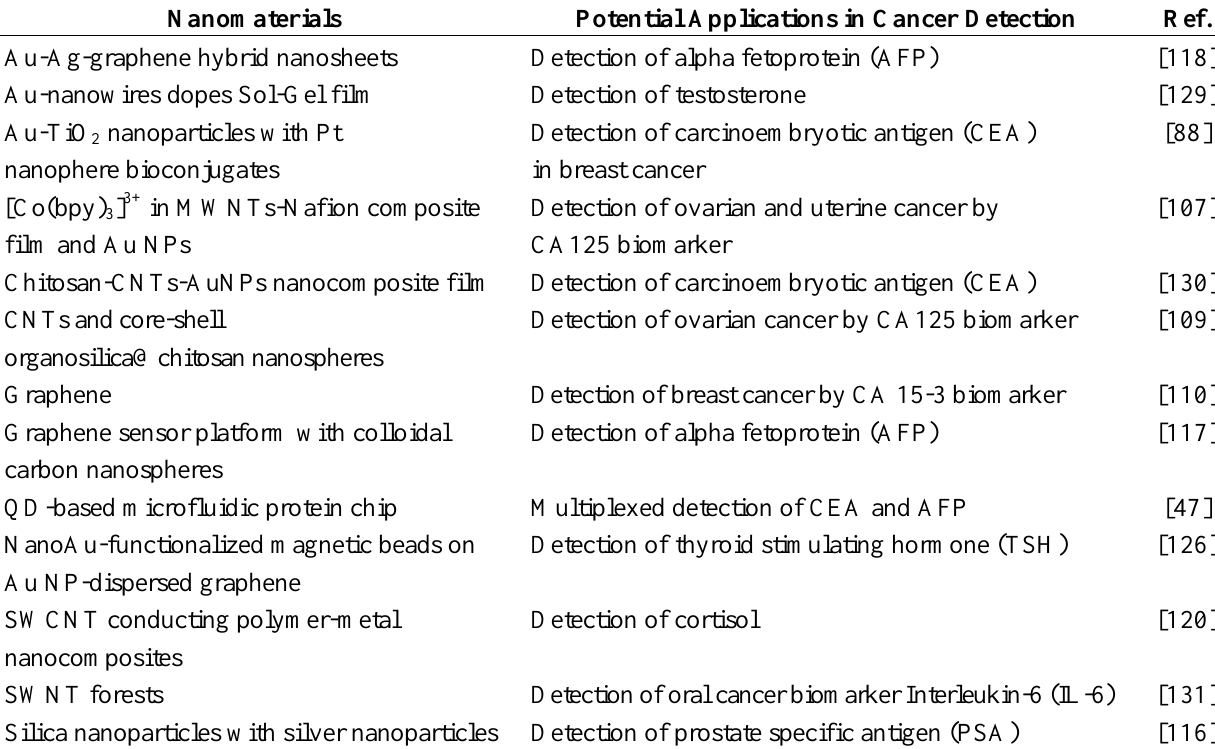
Table 3. Nanomaterials and their applications in